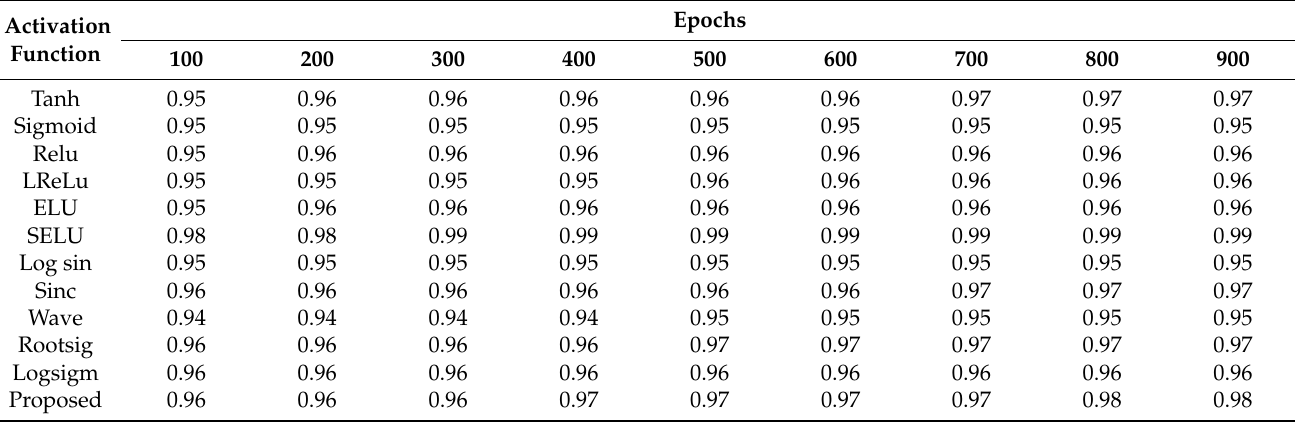
Table 2. Comparison of accuracy proposed with state-of-the-art activation functions on different epochs.